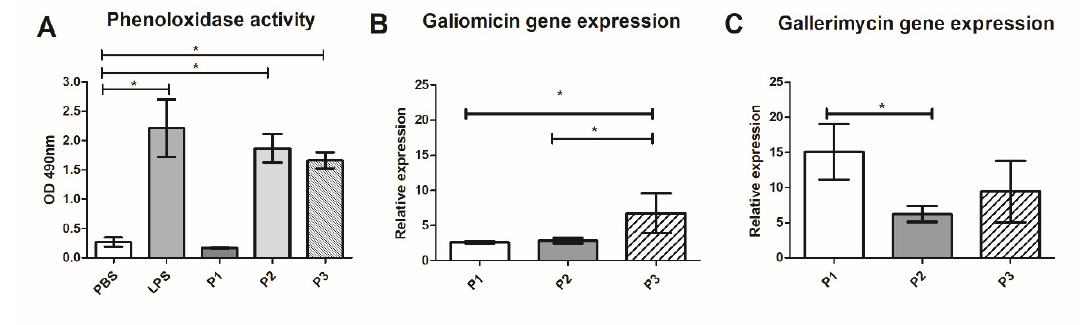
Figure 5. Effect of 14-3-3 protein peptides in humoral response of G. mellonella. Induction of G. mellonella phenoloxidase enzyme after treatment of 14-3-3 peptides using L -dopa as substrate ( A ). Relative expression G. mellonella of peptides galiomicin ( B ) and gallerimycin ( C ) genes after treatment of 14-3-3 peptides. Data expressed as mean ± standard deviation of three biological replicates and three independent experiments (* p < 0.05), using Kruskal-Wallis and Dunn’s for phenoloxidase enzyme activity and gene expression using Student’s t -test. Lipopolysaccharide